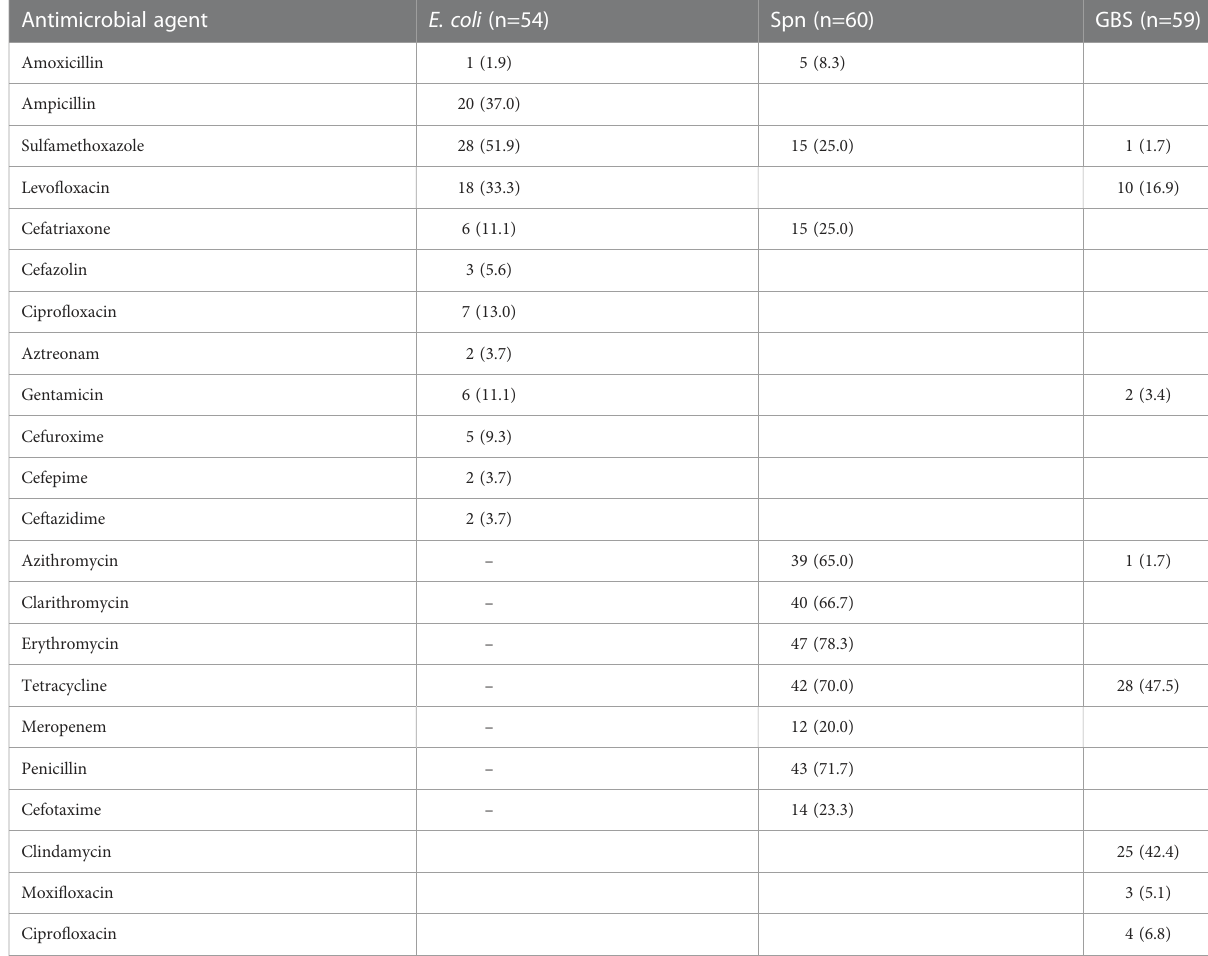
TABLE 3 Resistance rates (A/B) (%) of the three common bacteria isolated from BM patients. Antimicrobial